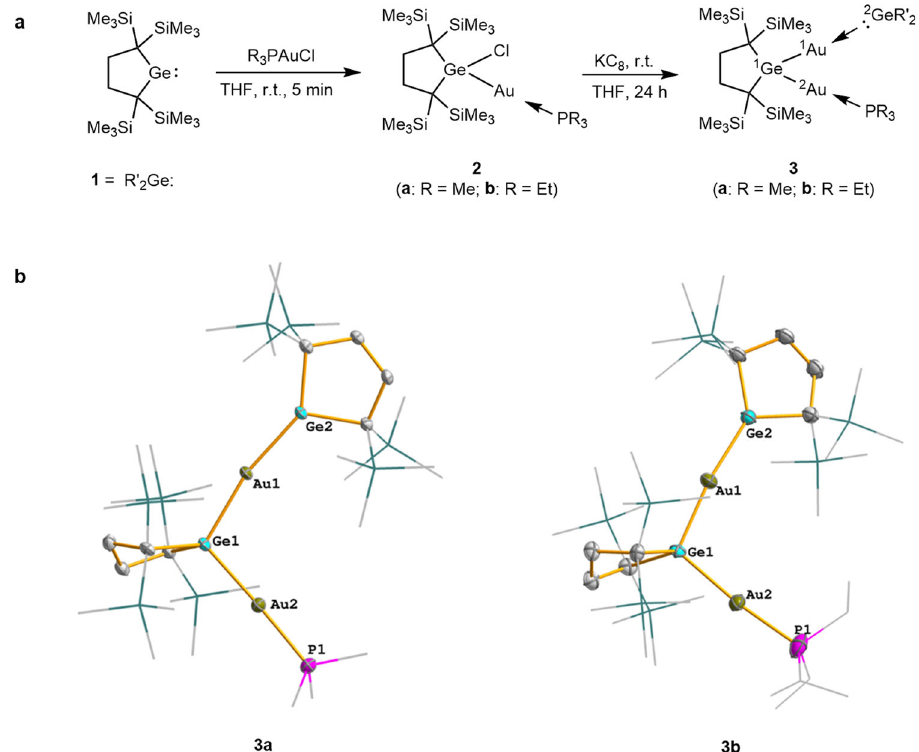
Fig. 2 Synthesis and characterization of 3a and 3b. a The synthesis of digoldgermanes 3a and 3b . b Molecular structures of 3a and 3b ; hydrogen atoms are omitted for clarity. Trimethylsilyl, ethyl, and methyl groups are depicted in a wireframe